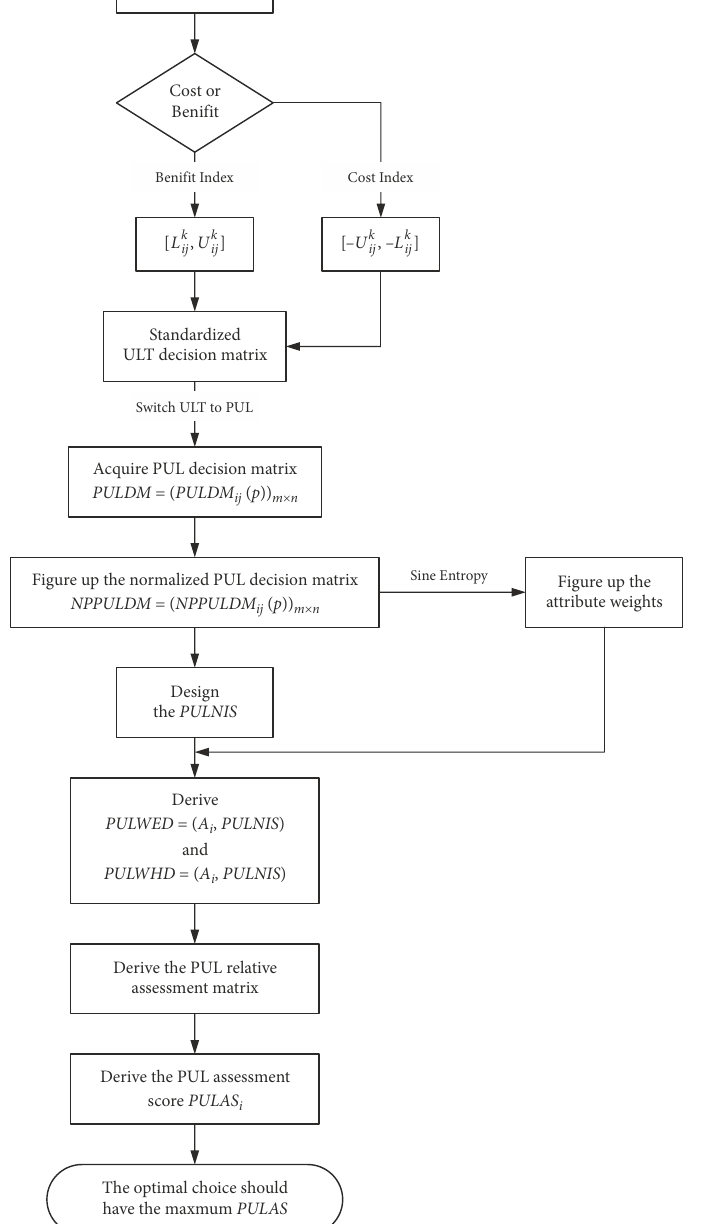
Figure 1. The flowchart of the CODAS method for the PUL-MAGDM